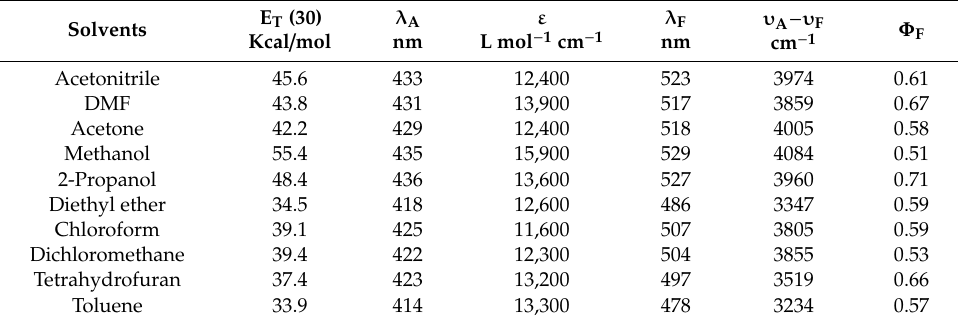
Table 2. Spectral characteristics of compound NI3 in organic solvents.